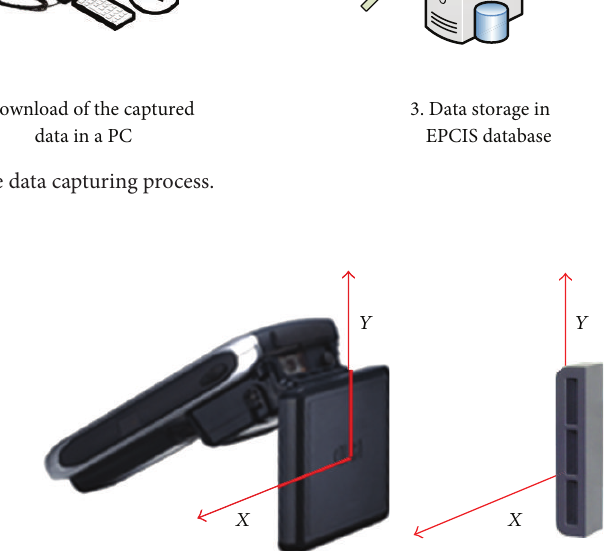
Figure 2: Coordinate system to establish a reference for the tag orientation.